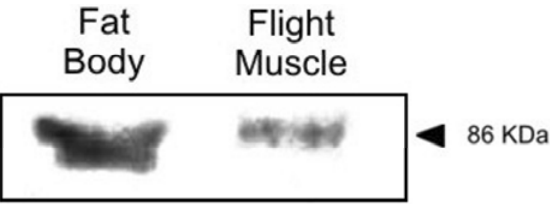
Fig. 9 – PFK content on fat body and flight muscle homogenates. PFKcontentwascomparedinbothtissuesbywestern-blottinganalysis. Protein at a content of 150 micrograms was applied on each lane. A molecular mass of 86 KDa was obtained by comparison with relative mobility of several standard proteins. Picture is representative of 4 independent